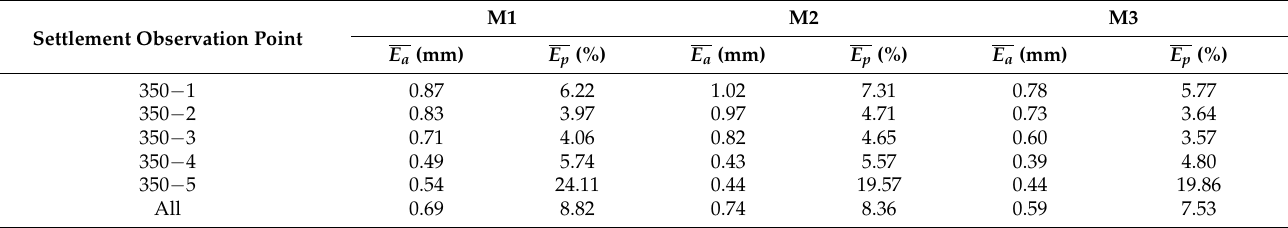
Table 4. Average prediction errors of M1, M2, and